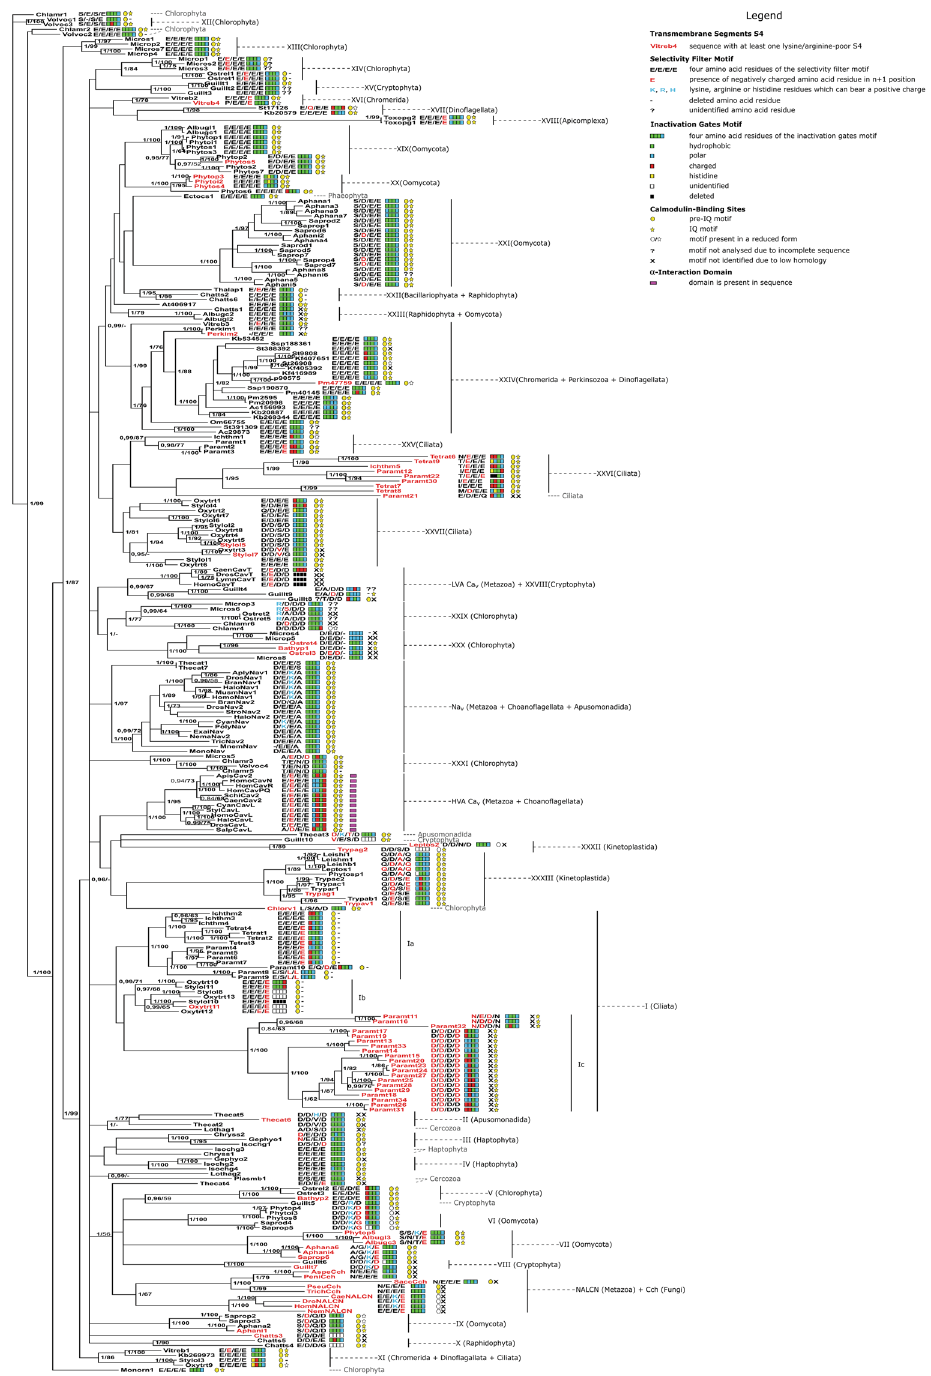
Figure 3. Functional determinants of four-domain voltage-gated cation channels of eukaryotes mapped on their full Bayesian phylogenetic tree.Bootstrap values < 65 and posterior probabilities < 0.95 are not